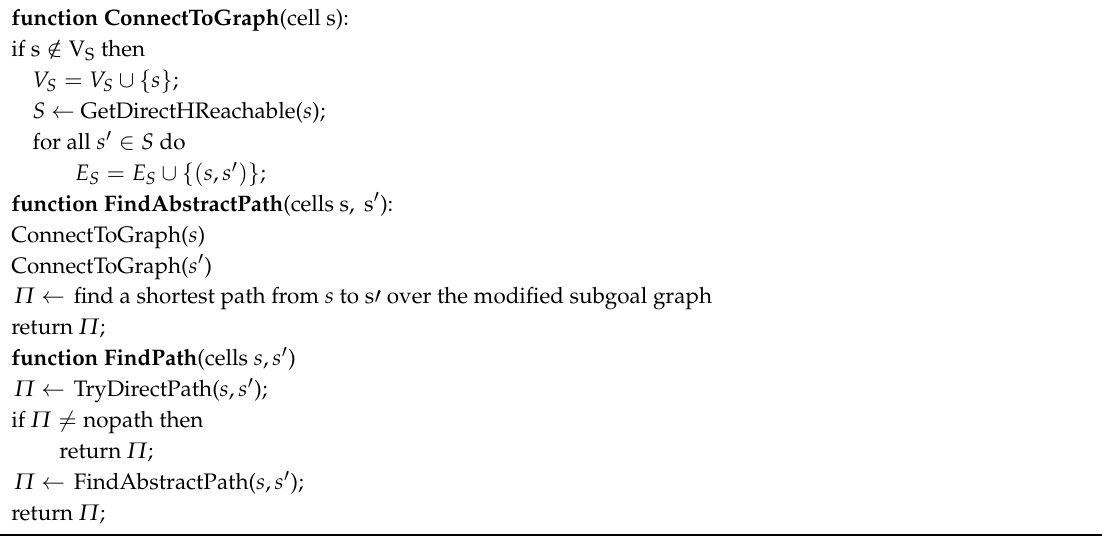
Algorithm 1 Searching subgoal graphs Pseudo-code of simple subgoal graph